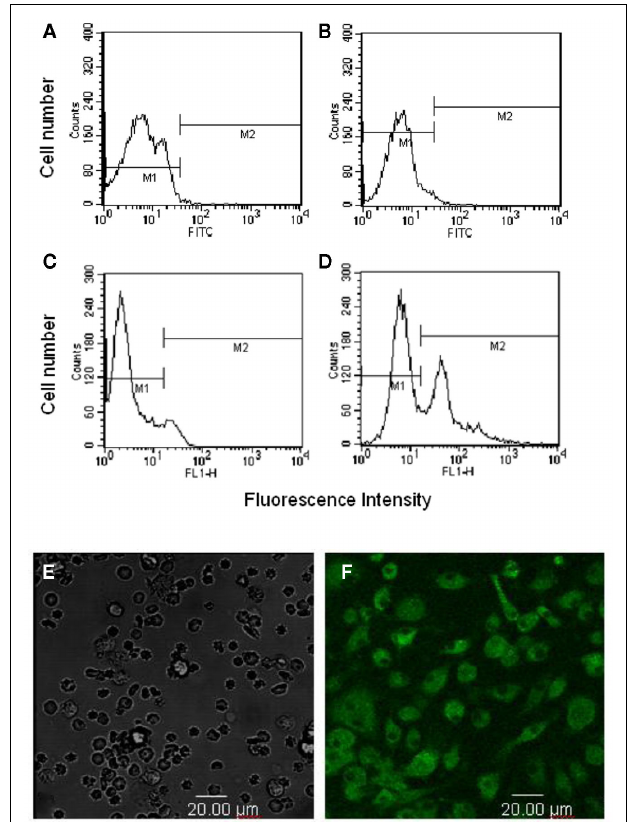
FIGURE 3 | Selective binding of FITC– Gl -PS to BMSC. Non-adherent hematopoietic cells (A,B) and adherent BMSC (C,D) were stained with FITC-Dextran [negative control (A,C) ] or FITC– Gl -PS (B,D) for flow cytometric analysis. Hematopoietic cells (E) and BMSC (F) stained